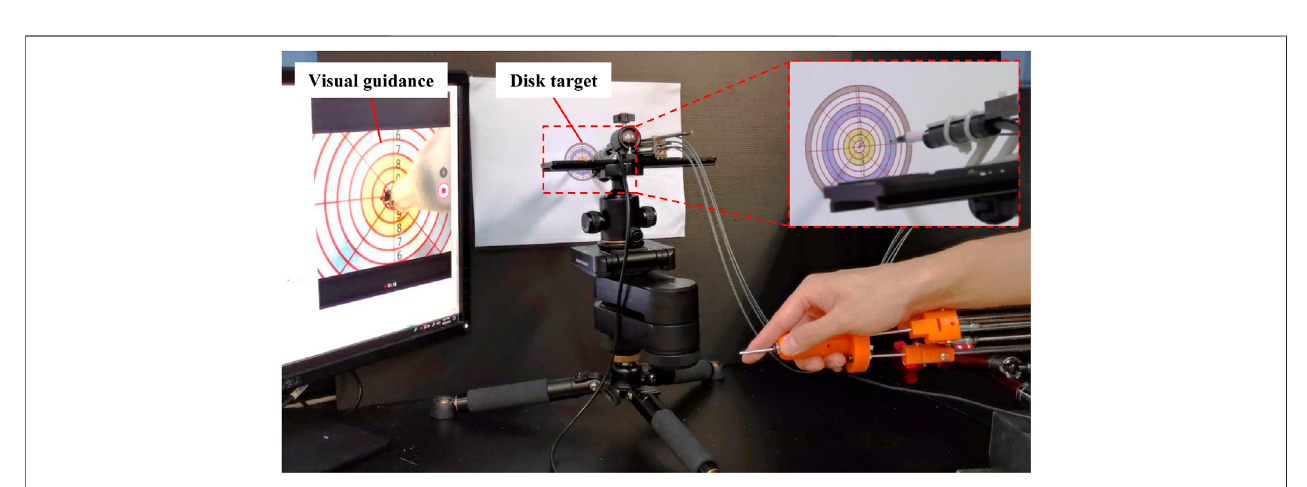
FIGURE 4 | Setup for the accuracy tests of master-slave operation under the visual guidance.